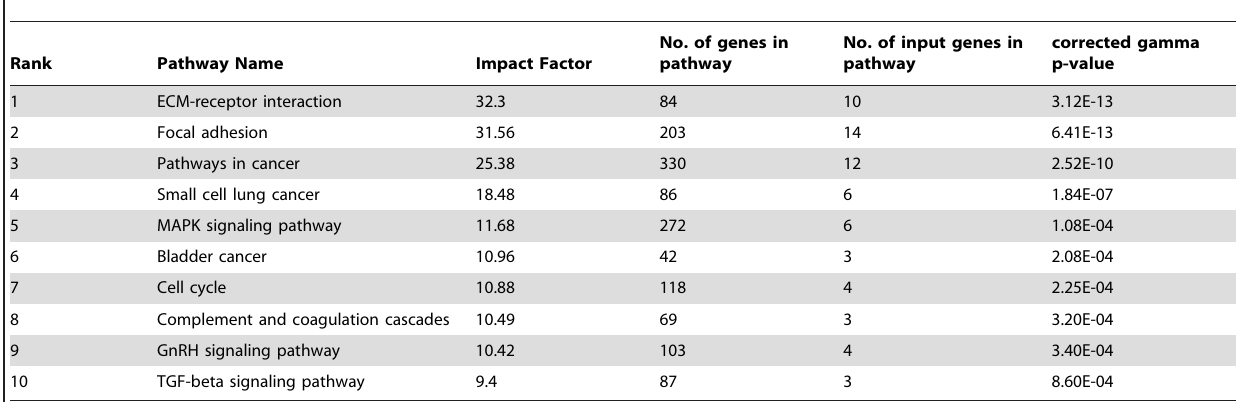
Table 3. Top differentially regulated KEGG pathways between AA and GBM as identified by Pathway Express.